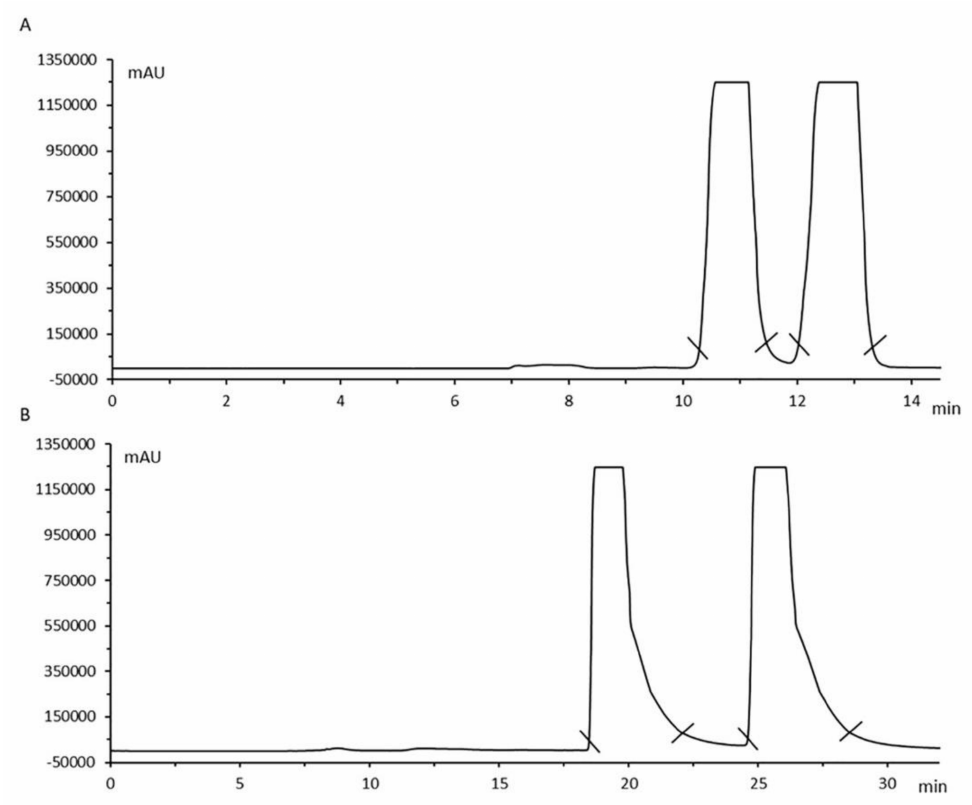
Figure 17. Chromatograms of the semipreparative enantioseparation of pentedrone ( A ) and methy- lone ( B ). (Reprint with permission from [111], Copyright (2018)